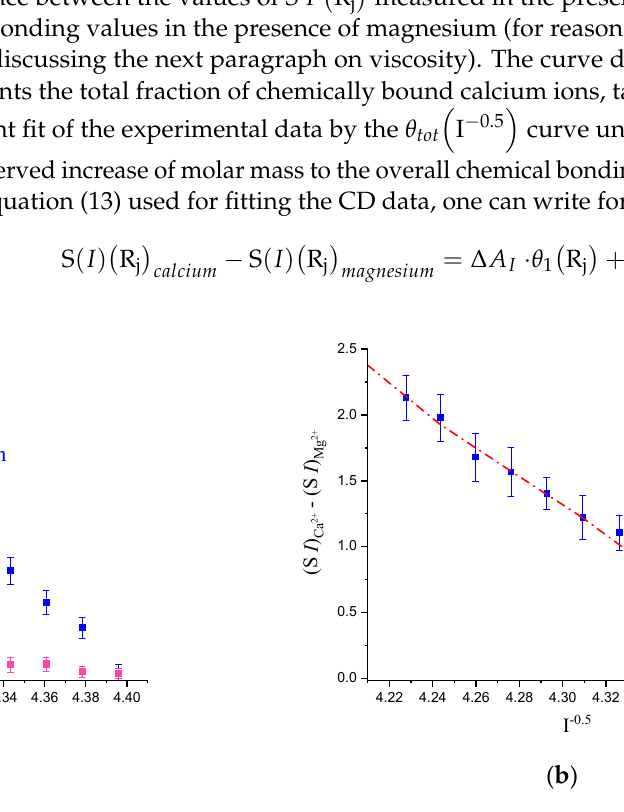
Figure 13. ( a ) Dependence of the relative scattering intensity increase at 90°, S I , on the reciprocal of the square root of the ionic strength, I, for the addition of Ca 2+ ions (blue full squares) and Mg 2+ ions (pink full squares) to L. hyp. alginate in aqueous NaCl 0.05 M. ( b ) Blue full squares: dependence on the reciprocal of the square root of the ionic strength, I, of the difference of the relative scattering intensity at 90°, S I , between the data with Ca 2+ ions and those with Mg 2+ ions of panel ( a ); red dash-dotted curve: dependence on the reciprocal of the square-root of the ionic strength, I, of the total fraction of chemically bound Ca 2+ ions to L. hyp. alginate (r.h.s. ordinate).